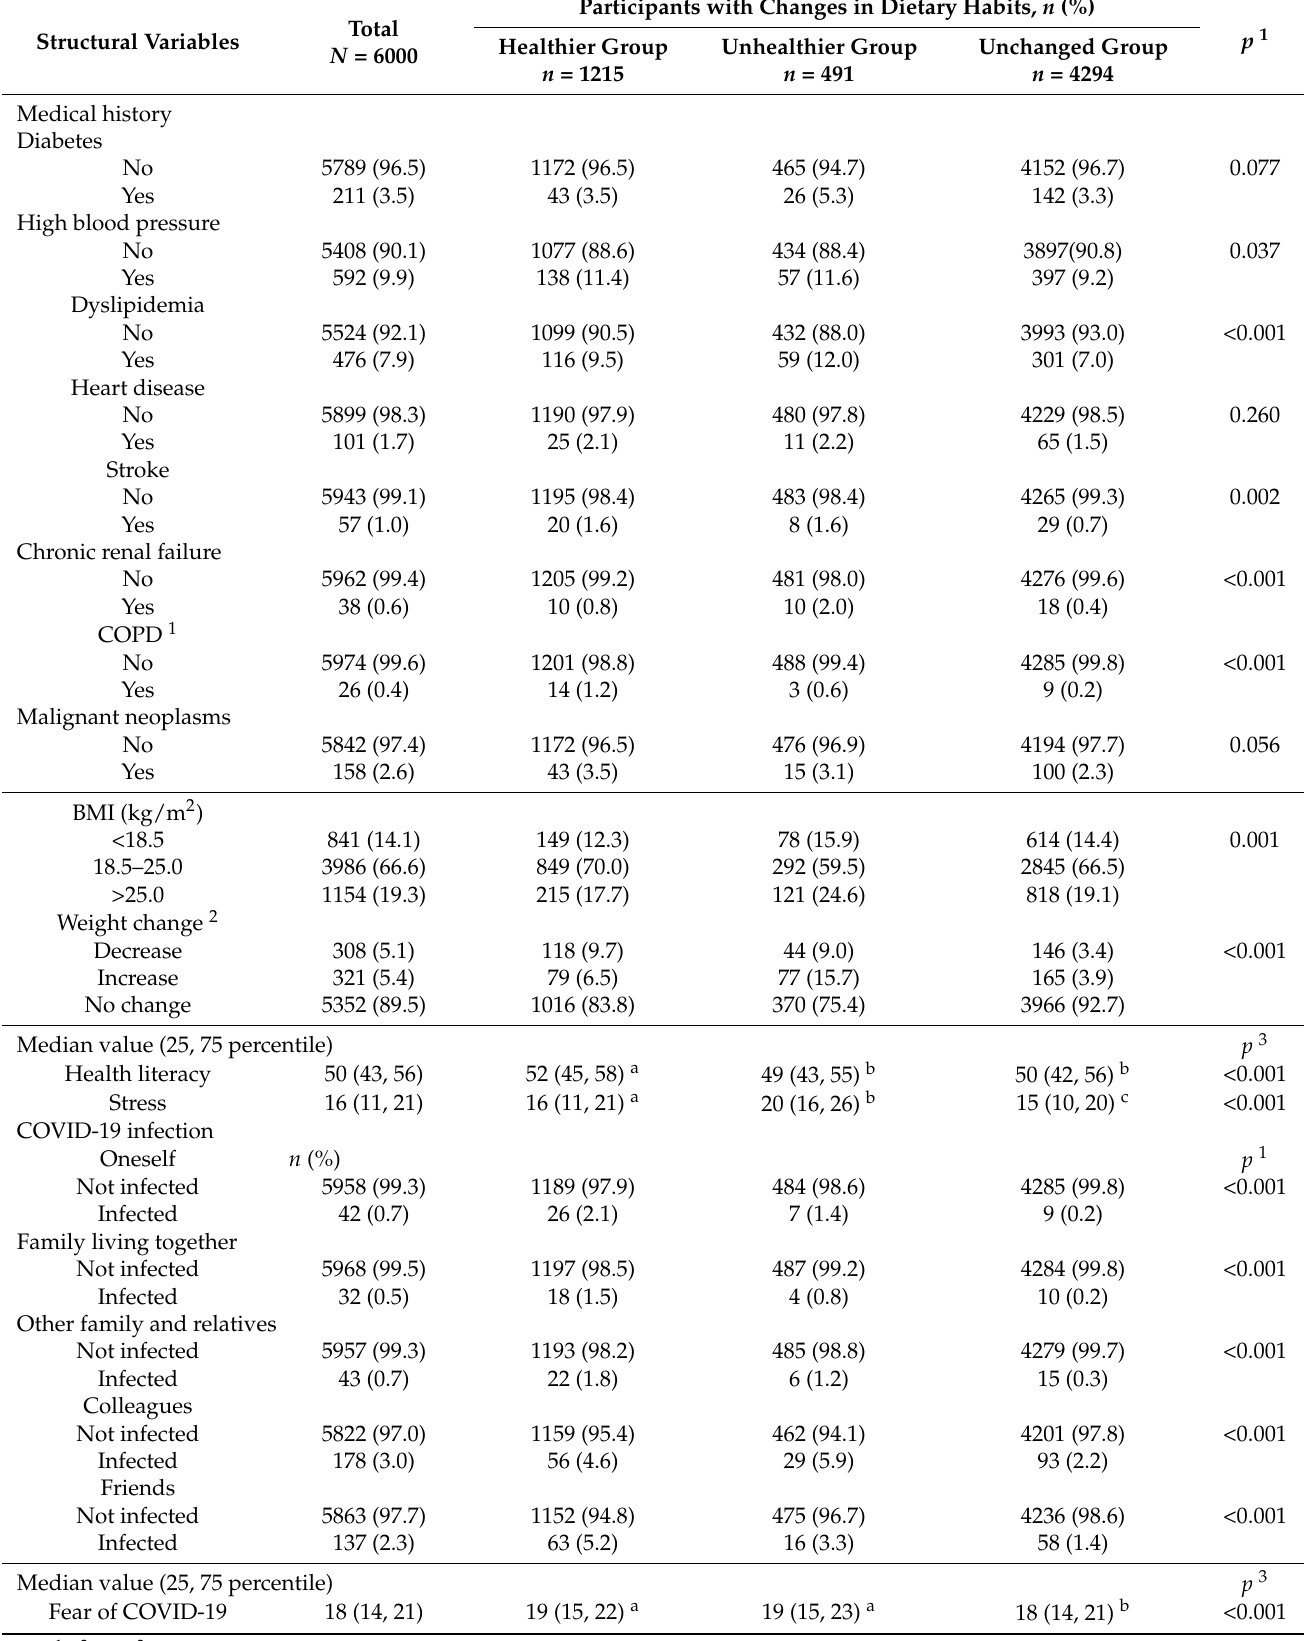
Table 3. Comparison of structural variables among the healthier, unhealthier, and unchanged groups.